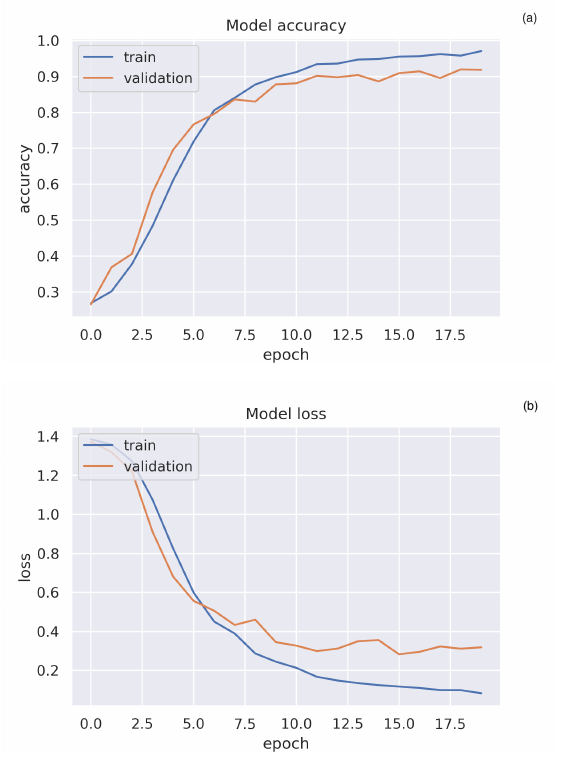
Figure 16. Results for the training of the deep learning (DL) network. ( a ) Training and validation loss of the trained DL network. ( b ) Training and validation accuracy of the trained DL